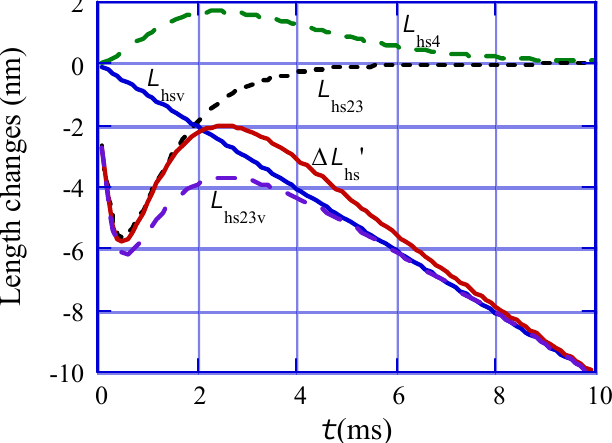
, L , L , L and  L ’ are illustrated in the case hs4 hsv hs23 hs23v hs